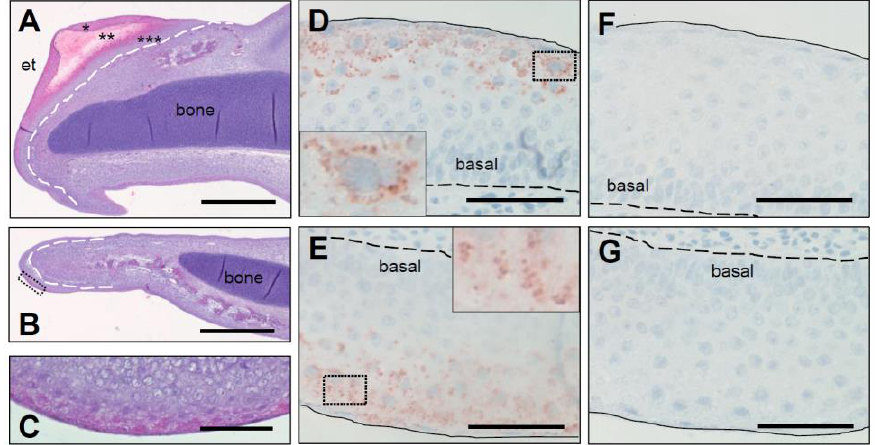
Figure 5. Expression of SCFN protein in the embryonic chicken egg tooth. Sections through the upper beak ( A , D , F ) and the lower beak ( B , C , E , G ) of chicken embryos at developmental stage E10 were immunohistologically stained with hematoxylin and eosin ( A – C ) or with mouse anti-SCFN serum ( D , E ). As control, anti-SCFN was blocked with the immunogen ( F , G ). The box in B indicates the area shown in a higher magnification in C. Insets in D and E show higher magnification of SCFN granules from the boxed areas of the sections. *, peridermal compartment of the egg tooth; **, cornified egg tooth; ***, beak underneath the egg tooth. et, egg tooth. Bars: 400 µm ( A , B ); 40 µm ( C – G ).